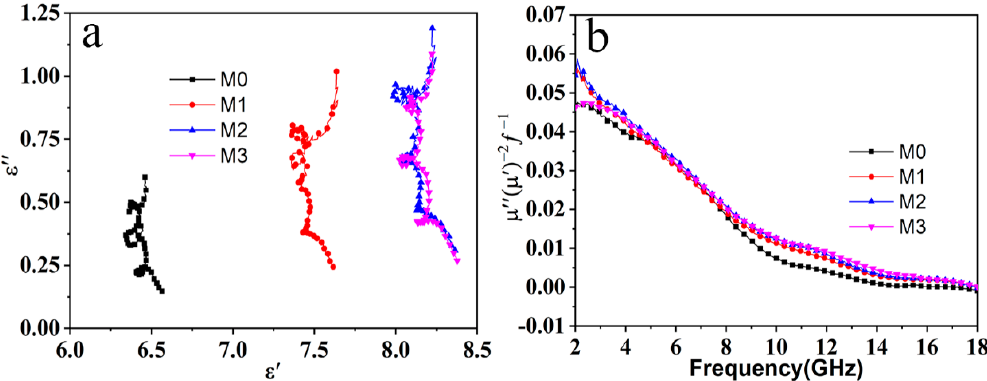
Figure 8. Cole − Cole semicircles ( a ), the curves of μ″ ( μ′ ) − 2 f − 1 versus frequency ( b ) for M0, M1, M2, and M3.